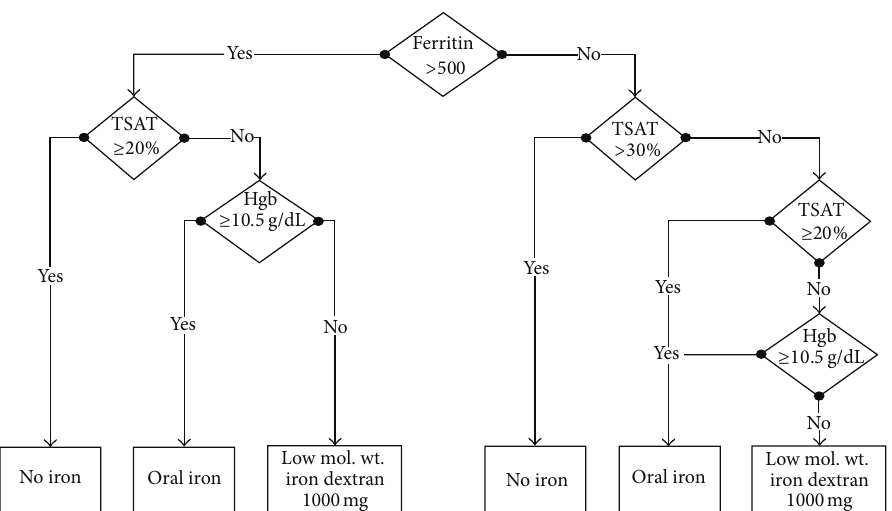
Figure 1: Computerized iron dosing protocol for CKD stages 3 and 4.